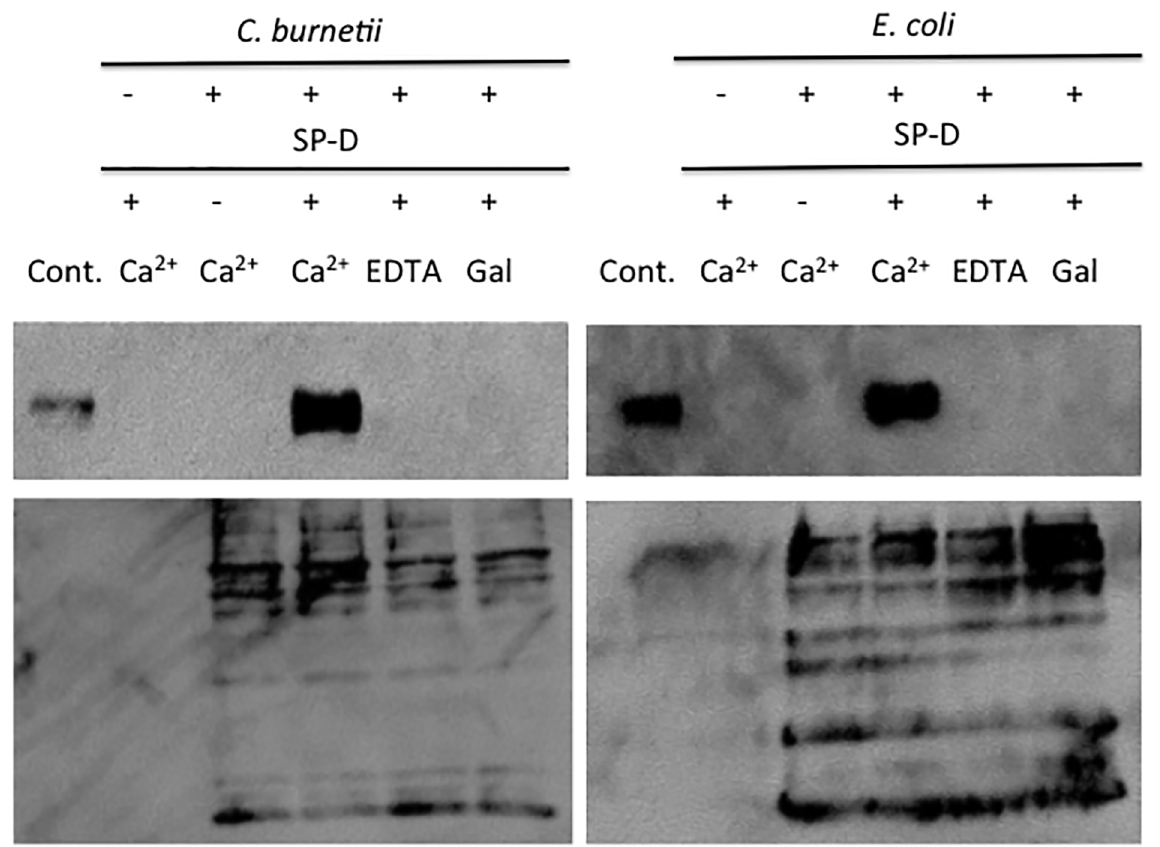
Fig 1. SP-D binds to C . burnetii in a calcium dependent fashion that can be inhibited by monosaccride. SP-D was incubated with C . burnetii or E . coli with or without EDTA or galactose, in PBS + CaCl 2 overnight at 37°C. Bacterial suspensions were then washed 3x with PBS by centrifugation. All samples were subjected to SDS-PAGE followed by blotting to detect SP-D that co-sedimented with the bacteria. SP-D was loaded as a positive control (left lane each blot labeled SP-D). Representative results are shown from 3 independent